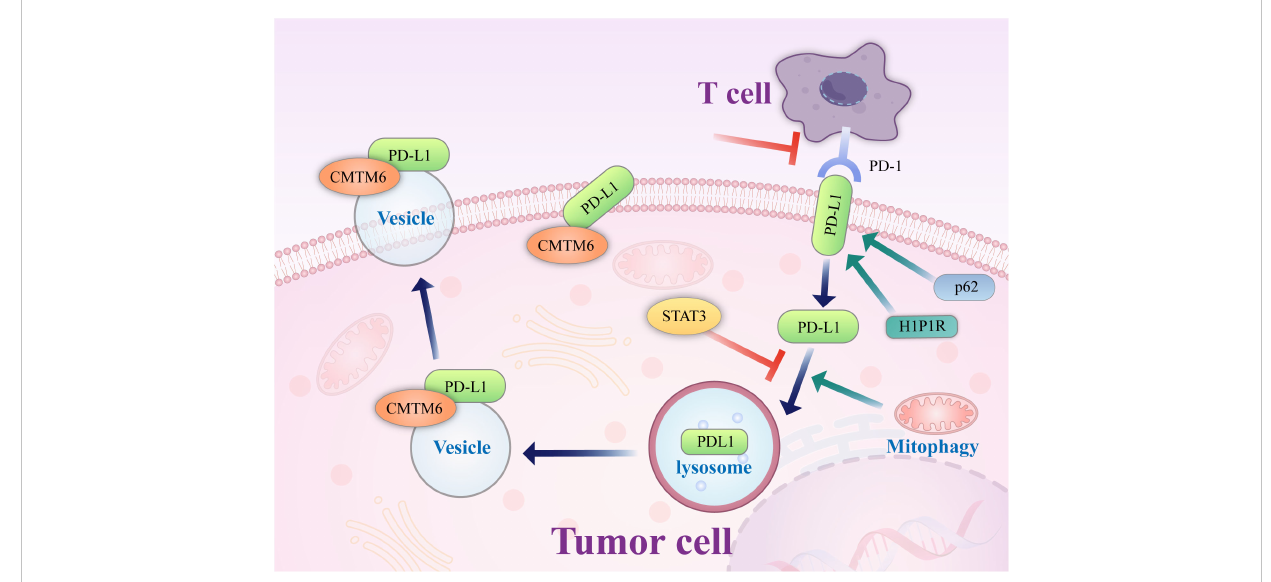
FIGURE 2 Mechanism of autophagy control. Autophagy controls PD-L1 expression via the histone deacetylases, p62/sequestosome-1/NF- k B pathway, STAT3 phosphorylation, ATG7/autophagy/FOXO3A/miR-145 axis, and autophagy fl ux in cancer cells. PD-1, programmed death-1; miRNA/miR, microRNA; PD-L1, programmed death ligand-1; p, Phosphorylated; HDAC, histone